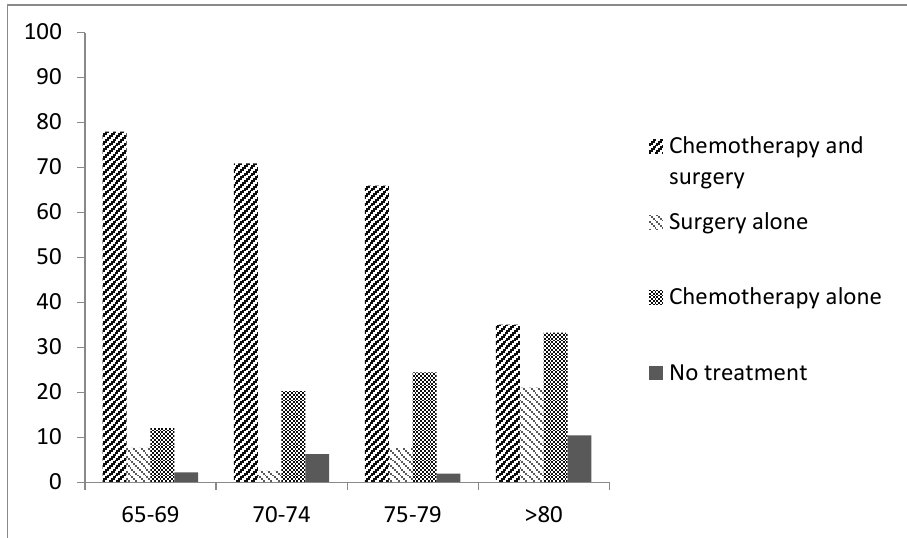
Figure 1. First-line treatment received according to age cohort. Figure 1. First -line treatment received according to age cohort.